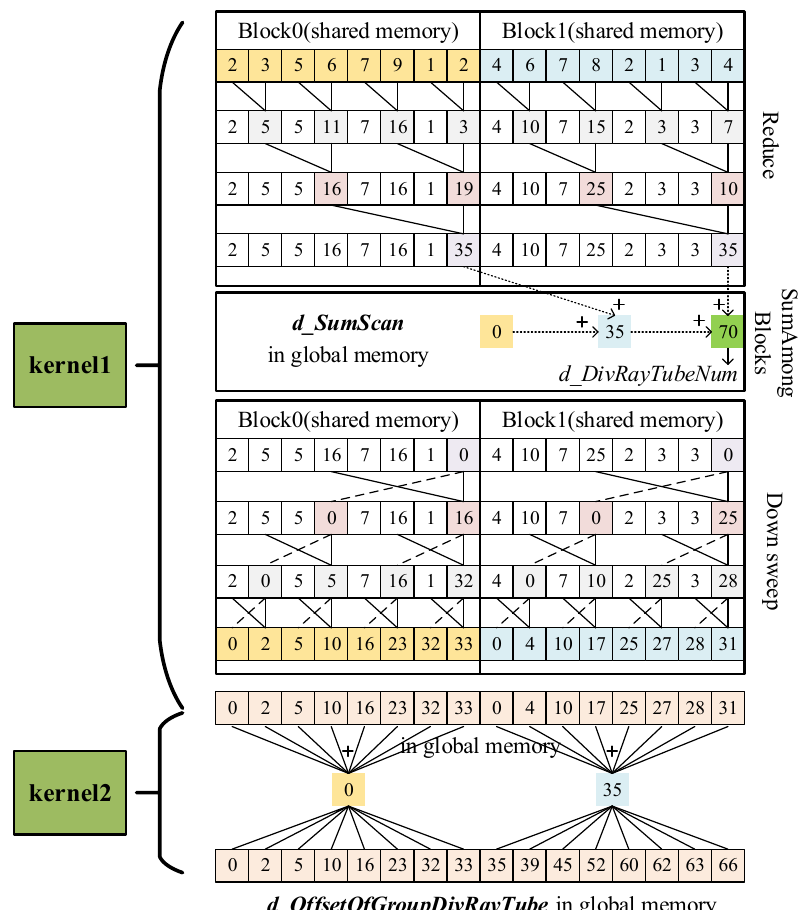
Y X Figure 3. The space vector illustration during target intensity calculation. 3. GPU-Accelerated Implementation for Multiresolution Grid Algorithm in SBR For the procedure of the GPU-accelerated multiresolution grid algorithm in the SBR, it is worth stating that we only need to track the newly generated corner rays of the first or second generation child ray tubes, rather than tracking all of their corner rays. Lastly, by superposing the integral result of each time, we obtain the TS value of the target in a particular incident direction. In order to take full advantage of the multi-core on GPU, we save the center ray of divergent ray tubes in the contiguous address space of global memory. Firstly, we use a group of 512 ray tubes and record the divergent information in the shared memory. In addition, by using the atomicAdd by CUDA, we calculate the number of divergent ray